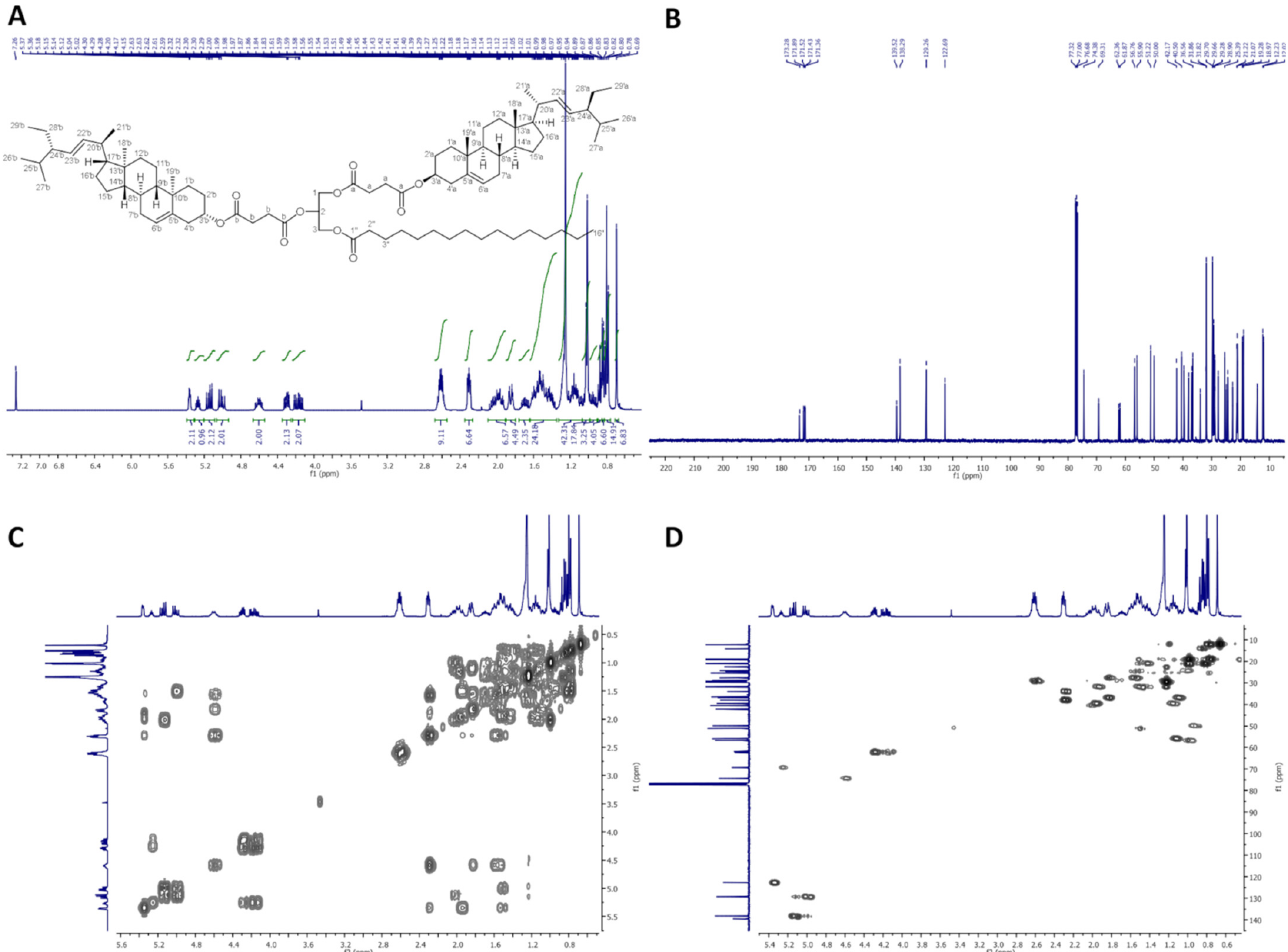
Figure 2. NMR spectra of dStigS-PA: ( A ) 1 H-NMR (400 MHz, CDCl 3 ), ( B ) 13 C-NMR (100 MHz, CDCl3), ( C ) COSY and ( D ) HMQC.